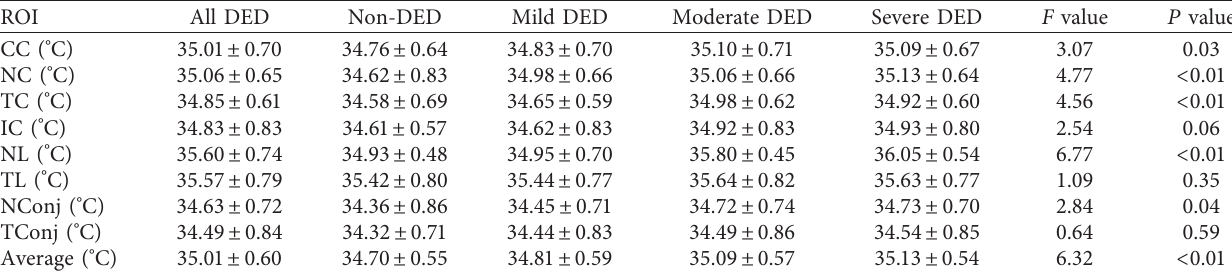
Table 2: Mean ocular surface temperature (OST) variation at various ROI.